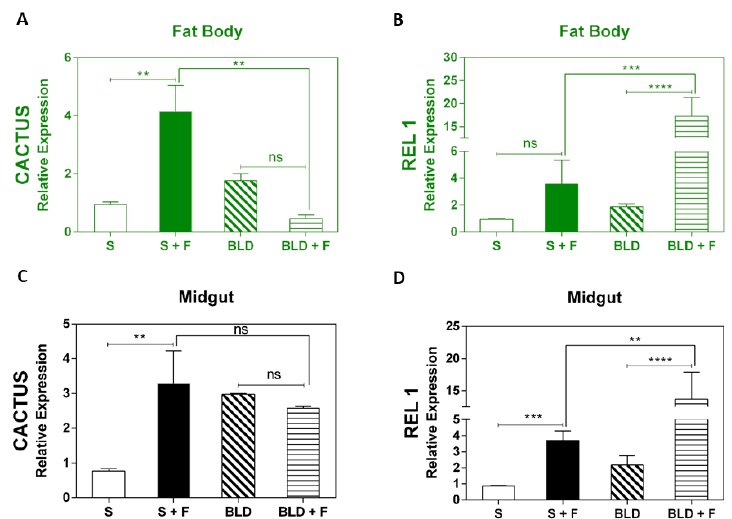
Figure 2. Expression analysis of TOLL pathway marker genes after exposure of A. aegypti to M. anisopliae . Gene expression analysis of Cactus and transcription factor REL1 in the midgut and fat body of sugar-fed or blood-fed insects at 48 h post-infection. The insects were fed with sucrose (10%) or mouse blood. After feeding, the insects were sprayed with M. anisopliae. Females at 48 h post fungal infection were dissected for total RNA extraction followed by synthesis of cDNA. cDNA was subsequently used to perform the RT-qPCR analysis. Each bar represents the results from a pool of 15 female mosquitoes. Results are the means of four independent experiments. The p- values from pair-wise comparisons (comparing Tween–treated to sugar-fed/blood-fed) were calculated using Student’s t -test and level of significance indicated for each bar (*: p < 0.05; b: ** p < 0.01; ***: p < 0.001; ****: p < 0.0001). Negative controls were treated with 0.05% aqueous Tween 80. Insects 2020 , 11 , x